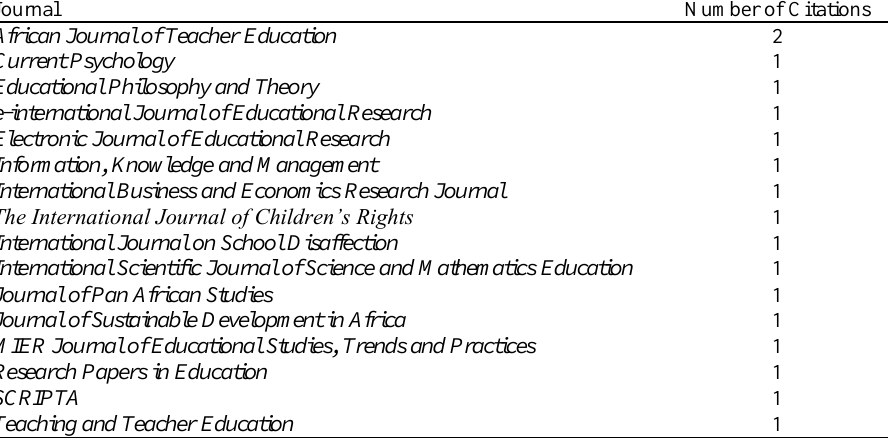
Table 8 International journals in which citations can be found from doctoral research completed in fields of education in South Africa in 2008; Citations by authors other than the doctoral